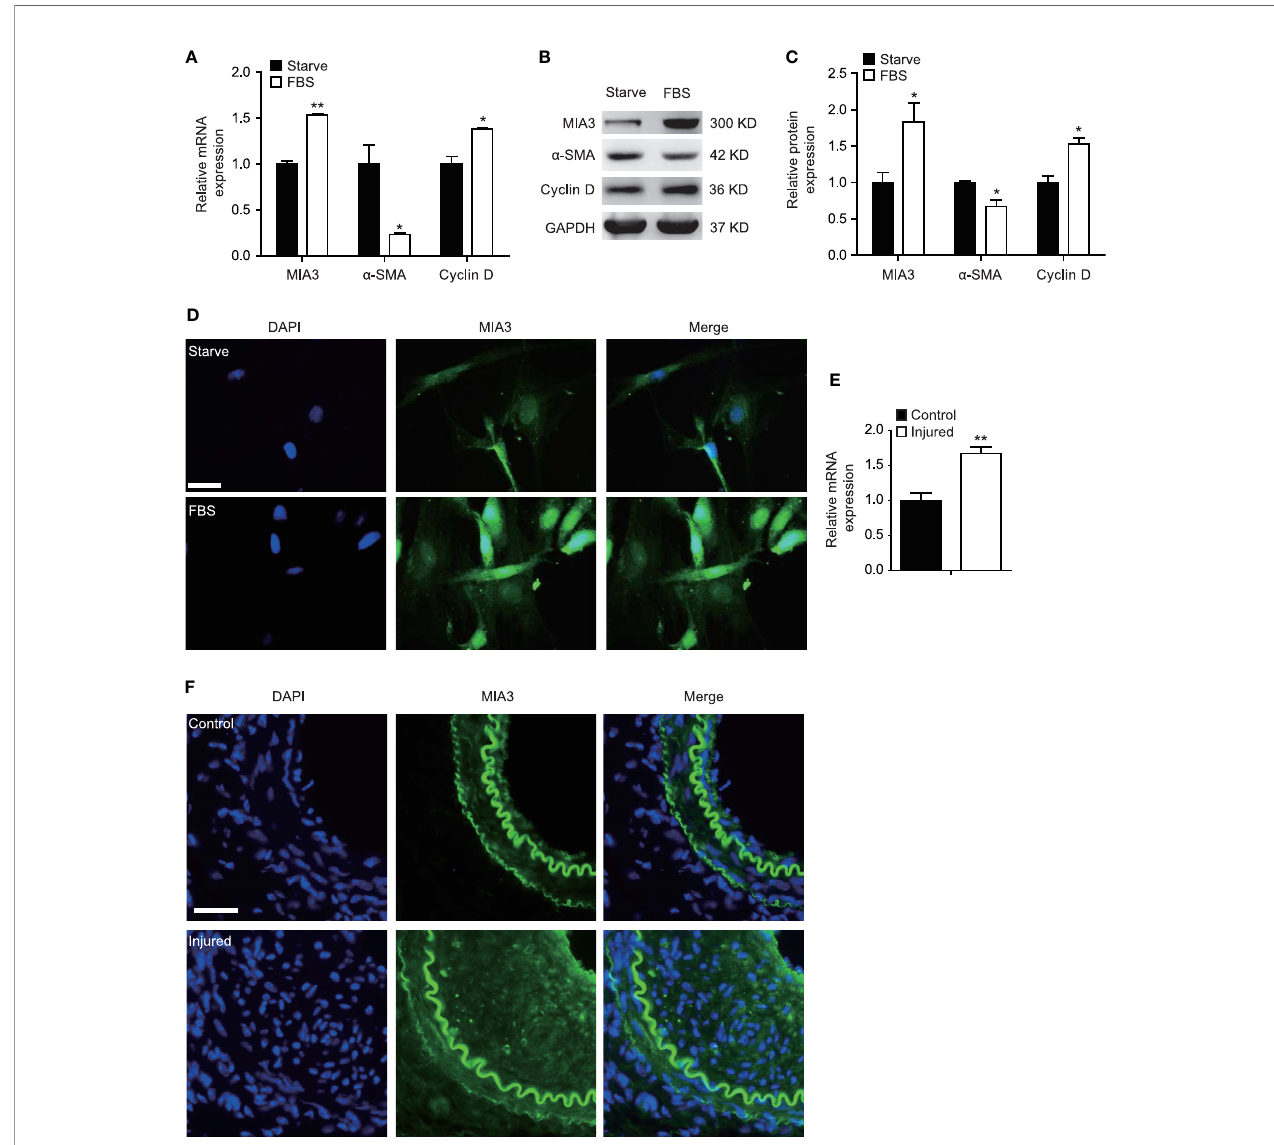
FIGURE 1 | MIA3 expression is increased in proliferative vascular smooth muscle cells (VSMCs). (A) mRNA levels of MIA3, a -SMA (smooth muscle a -actin), and Cyclin D1 by quantitative real-time reverse transcription polymerase chain reaction in VSMCs after treatment with medium containing 10% fetal bovine serum for 24 h and the control FBS-starve VSMCs. Data are represented as the mean ± SEM, n = 3. * p < 0.05, ** p < 0.01, t -test. (B) At 48 h after FBS treatment, VSMC extracts were collected for determining the protein levels of MIA3, a -SMA (smooth muscle a -actin) and Cyclin D1 by Western blotting. GAPDH served as loading control expression. (C) Quanti fi cation of protein expression normalized to the levels of GAPDH. Data are represented as the mean ± SEM, n = 3. * p < 0.05, t -test. (D) Immuno fl uorescent staining of MIA3 in VSMCs after treatment with medium containing 10% fetal bovine serum for 24 h and the control FBS-starve VSMCs. DAPI represents indicates 4 ’ ,6-diamidino-2-phenylindole throughout the article; scale bar: 50 m m. (E) mRNA levels of MIA3 by quantitative real-time reserve transcription polymerase chain reaction in femoral artery after wire injury for 28 days. Data are represented as the mean ± SEM, n = 3. ** p < 0.01, t -test. (F) Immuno fl uorescent staining of MIA3 in the femoral artery following wire injury for 28 days; scale bar: 100 m